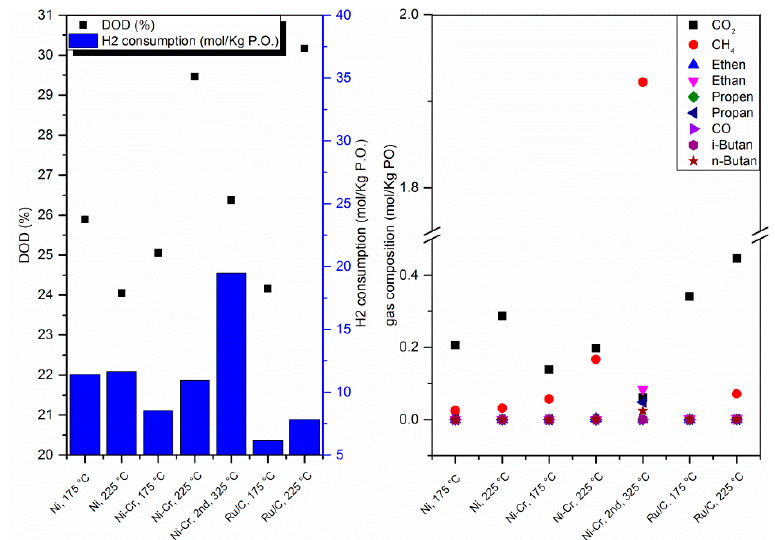
Figure 3. Degree of deoxygenation vs. hydrogen consumption ( left ) and gas composition ( right ) for the upgrading reactions conducted with BWBO and UBWBO.